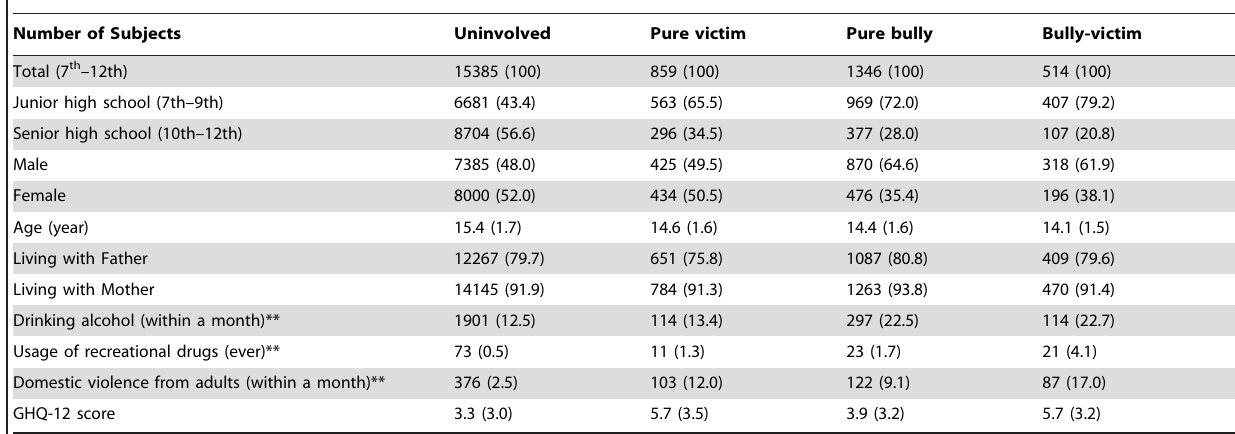
Table 1. Demographics of the